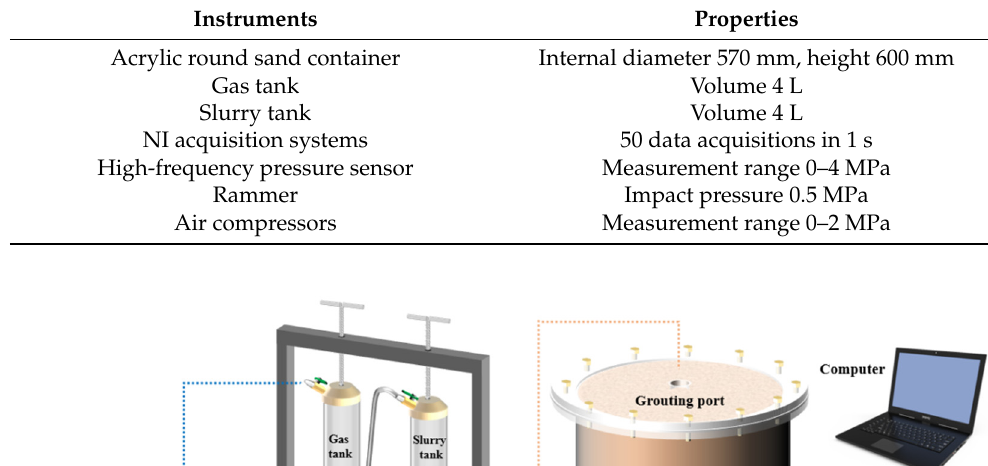
Table 3. Test equipment and instruments.